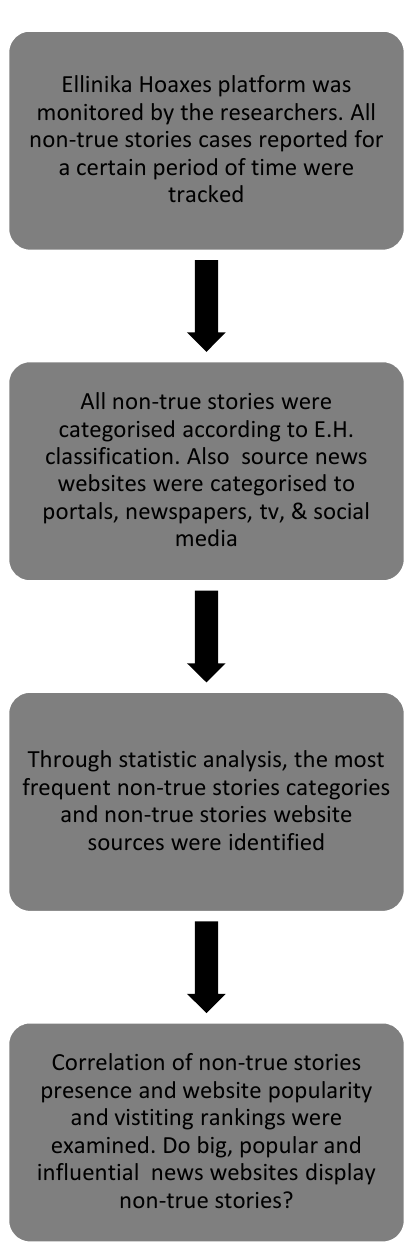
Figure 2. The summary of the methodology.